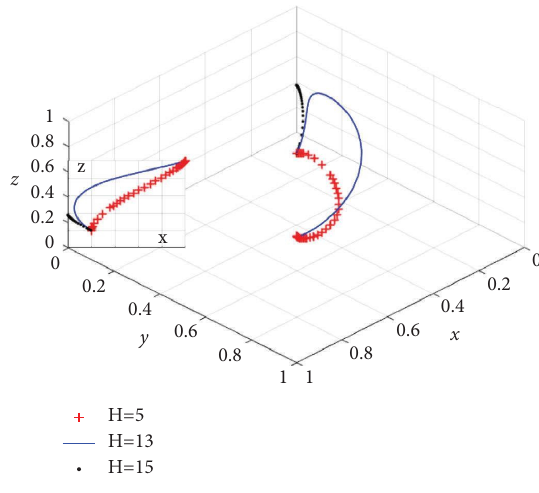
Figure 1: Sensitivity analysis of H .